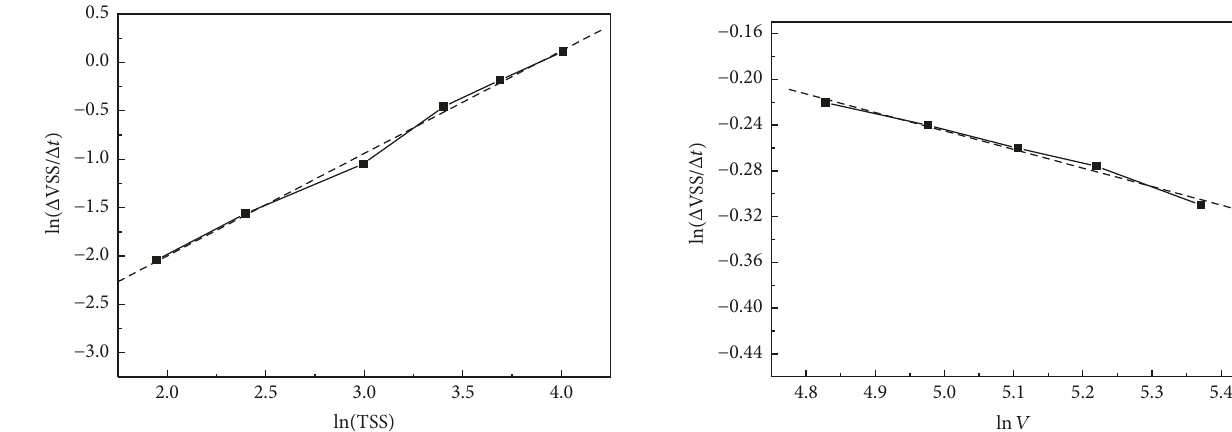
Figure 7: The relationship between VSS biodegradation rate and its concentrations. — ◼ — regression coefficient of 0.9955 for 𝑚 ; ------ ln (Δ VSS /Δ𝑡) = 1.05871 ln ( VSS ) − 4.1165 .